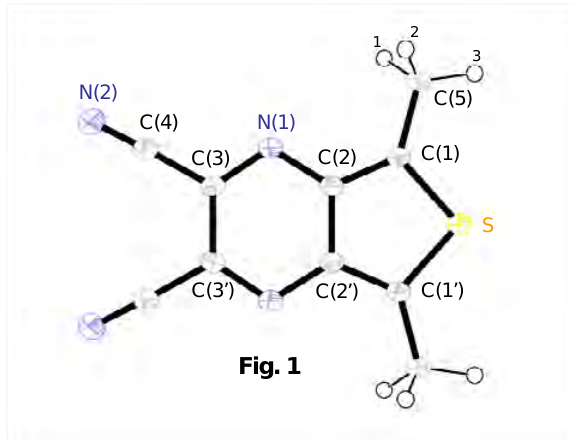
Figure 1. Molecular conformation of compound 5 . A few atoms generated by mirror